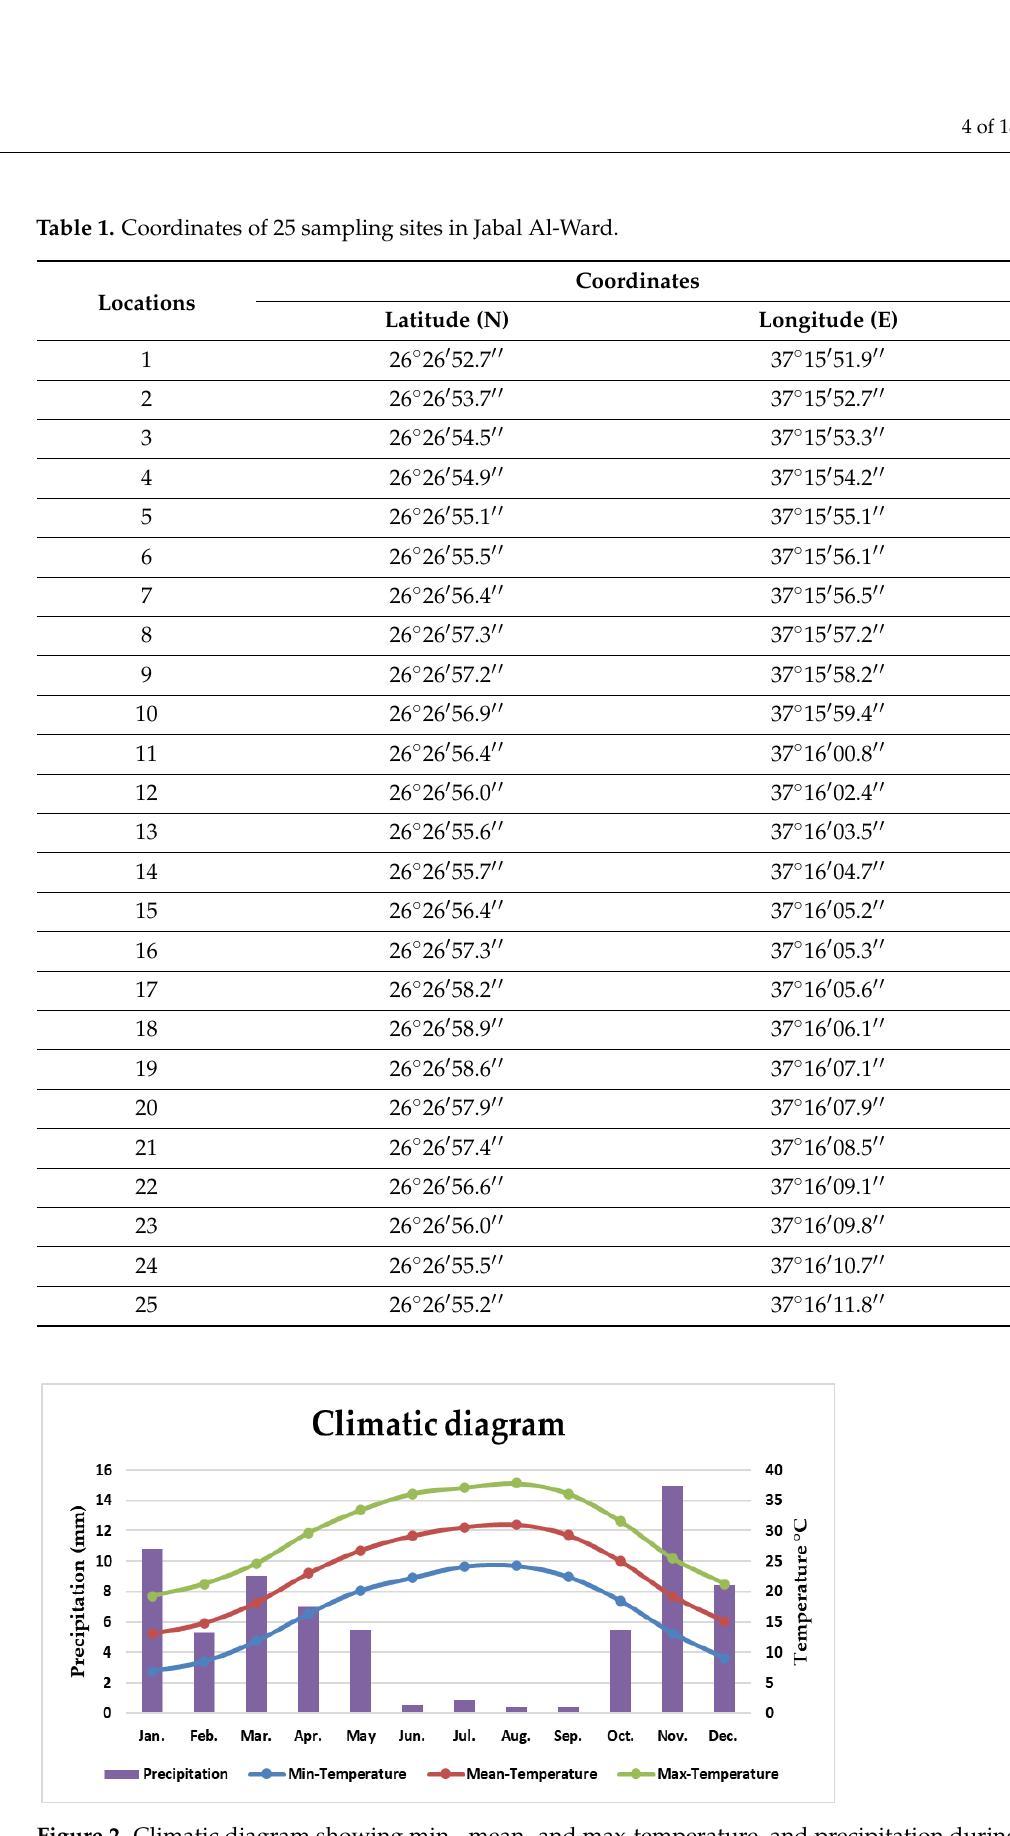
Figure 2. Climatic diagram showing min-, mean- and max-temperature, and precipitation during (1991–2020) in Tabuk, Saudi Arabia. The chart is based on the Climate Change Knowledge Portal data (CCKP 2021).